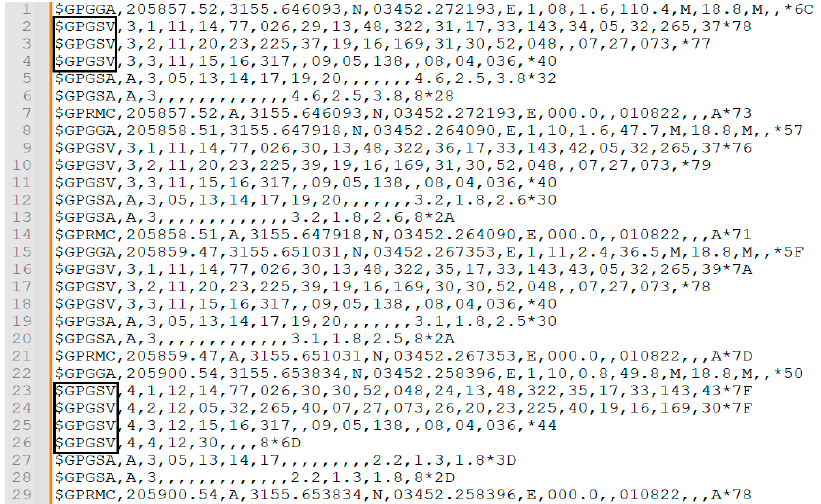
Figure A4. Case with different number of GPGSV lines.